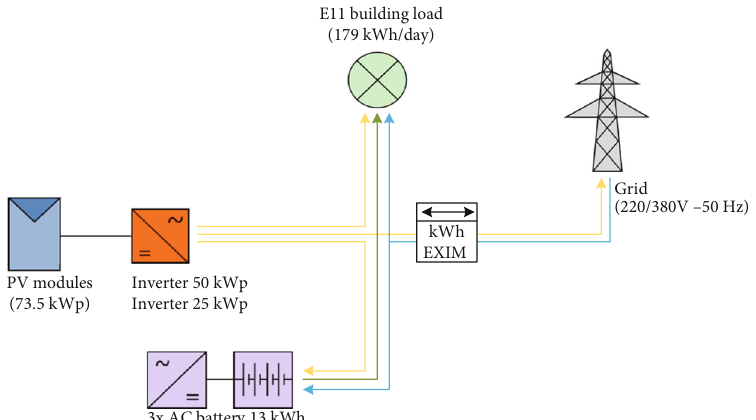
Figure 4: Scheme of BAPV connected to grid and BESS for E11 Building as scenario 1.